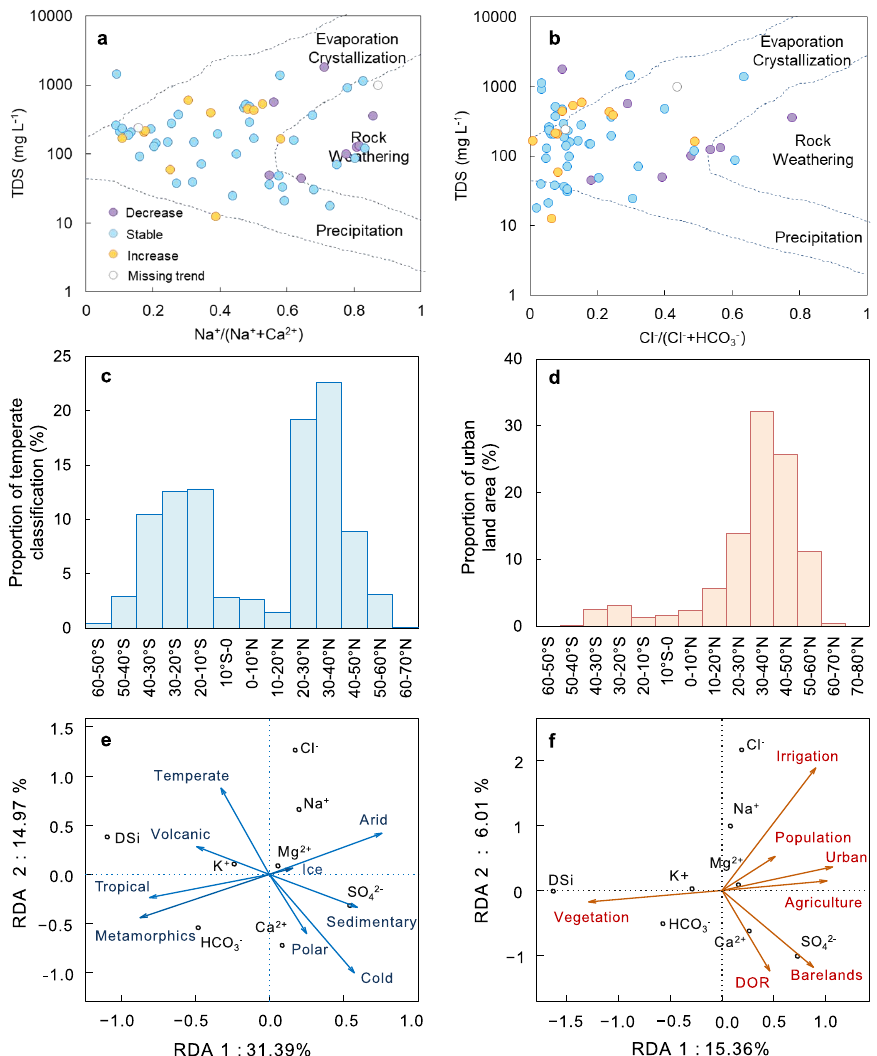
Fig. 5 Interpretation of natural and anthropogenic impacts on changes in solutes with river syndromes. a , b Gibbs model for stations with solute- induced river syndromes under varying trends in water discharge ( Q ). The 60 dots in purple, blue, and yellow respectively represent decreasing, stable, and increasing trends in the annual runoff. c , d are latitudinal distributions of proportional areas of temperate climate type and urban land area. e , f are redundancy analysis (RDA) results for the in fl uence on dissolved solids of natural factors (reclassi fi cation for Köppen climate and lithology) and anthropogenic factors (irrigation, population, degree of regulation (DOR), and detailed reclassi fi cation of land cover), in critical latitudinal